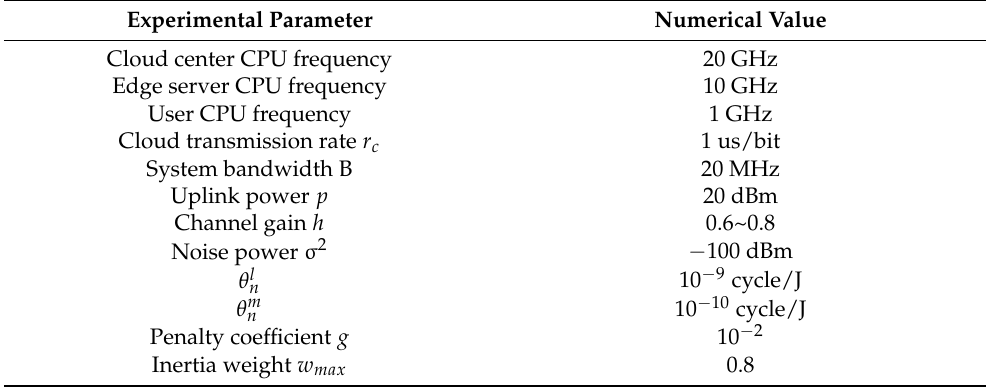
Table 1. Experimental parameters. Experimental Parameter Numerical